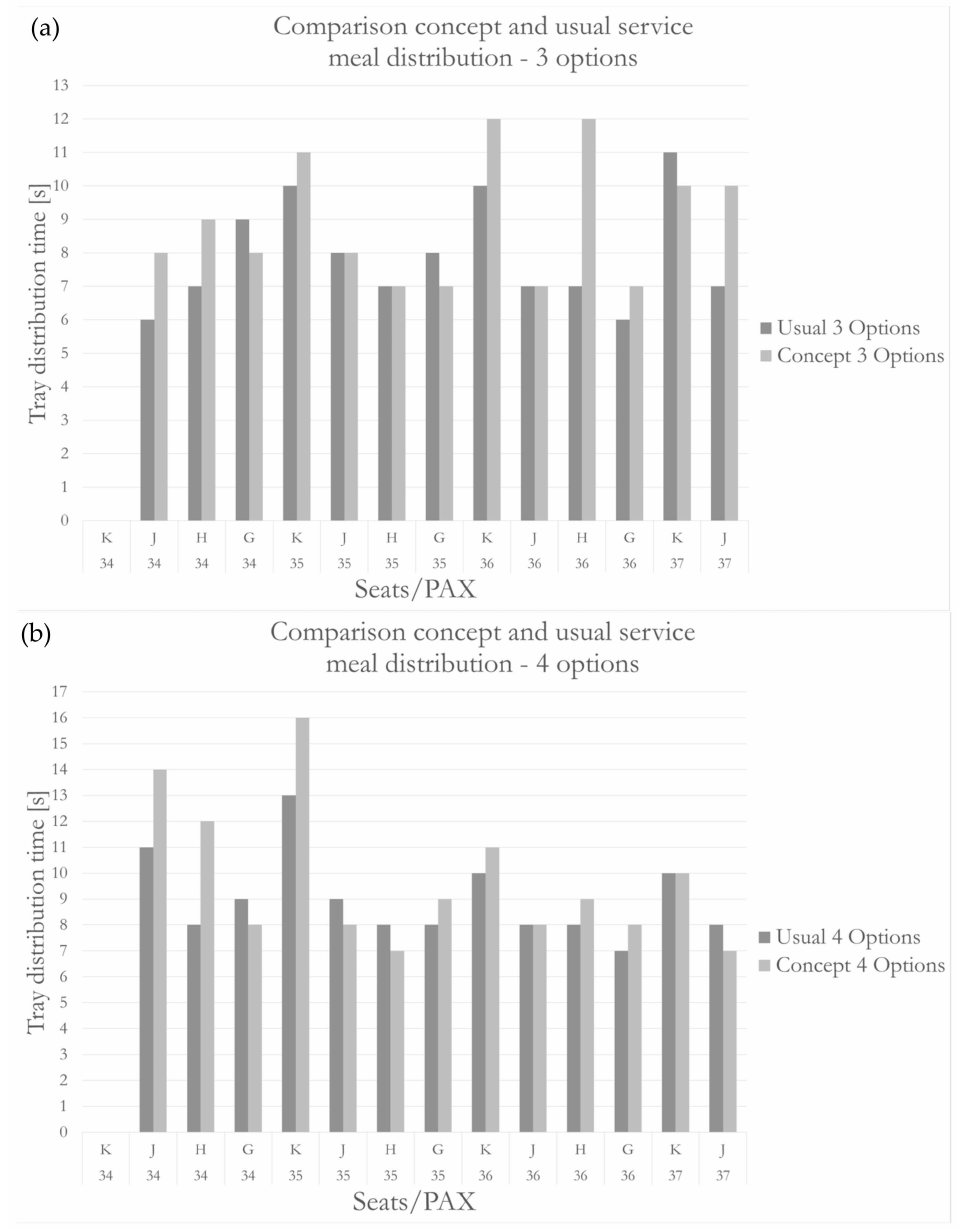
Figure 22. Service time for distribution with ( a ) 3 and ( b ) 4 meal